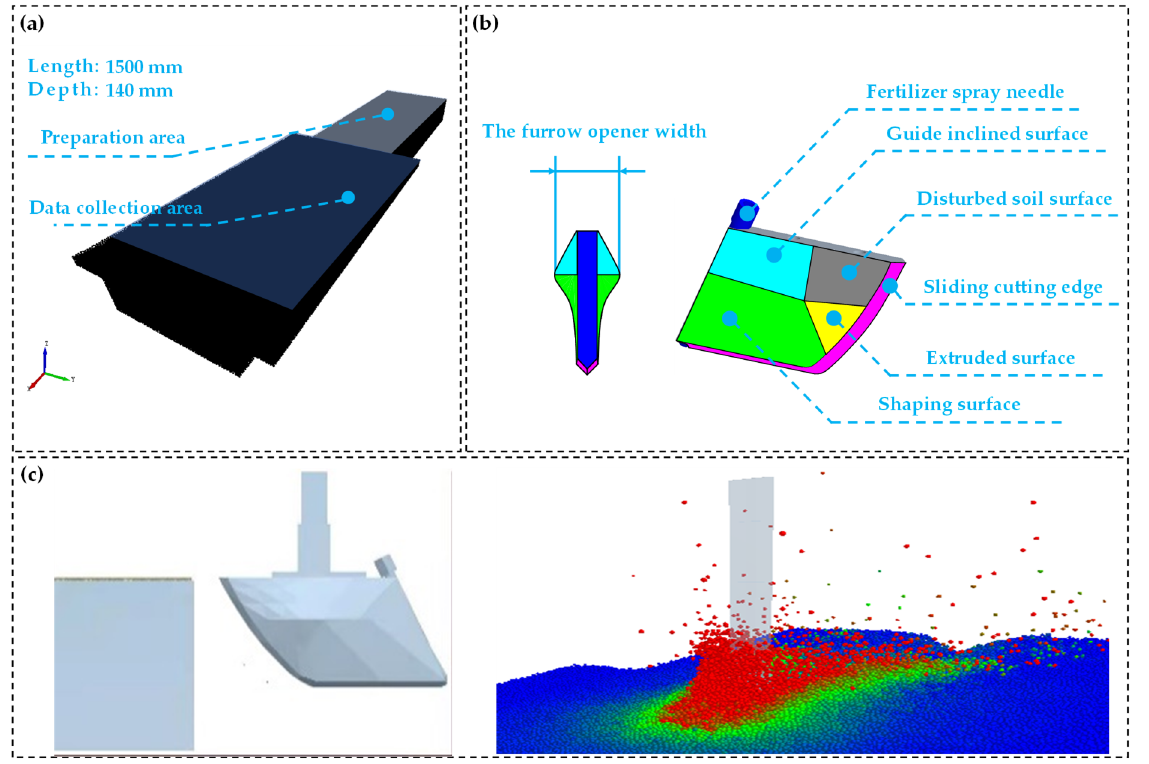
Figure 4. Construction and simulation process of the DEM virtual simulation model. ( a ) Construction of the DEM virtual simulation soil bin model. ( b ) Construction of the 3D model of high-efficiency soil-returning liquid-fertilizer deep-application furrow openers. ( c ) High-efficiency soil-returning liquid-fertilizer deep-application furrow opener and DEM virtual simulation test processes.